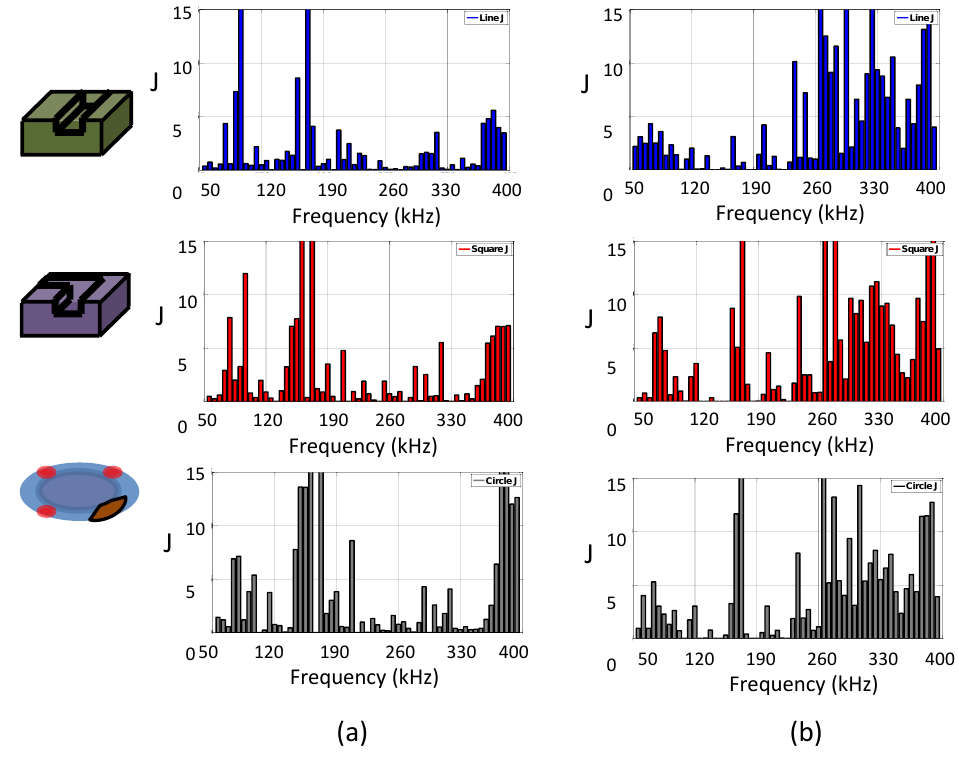
Figure 18. Classification index J calculated from data collected from different cutting tools: ( a ) tool 1; ( b ) tool 2.